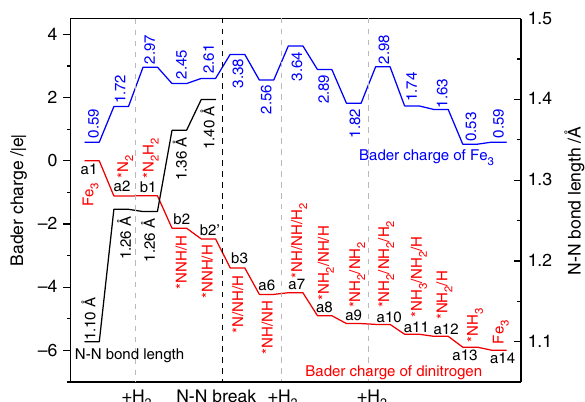
Fig. 4 Changes of N – N bond length and charges of Fe 3 and the adsorbates. Black, blue, and red curves represent N – N bond lengths, Bader charges of Fe 3 cluster, and Bader charges of dinitrogen at every step of the catalytic cycle with the